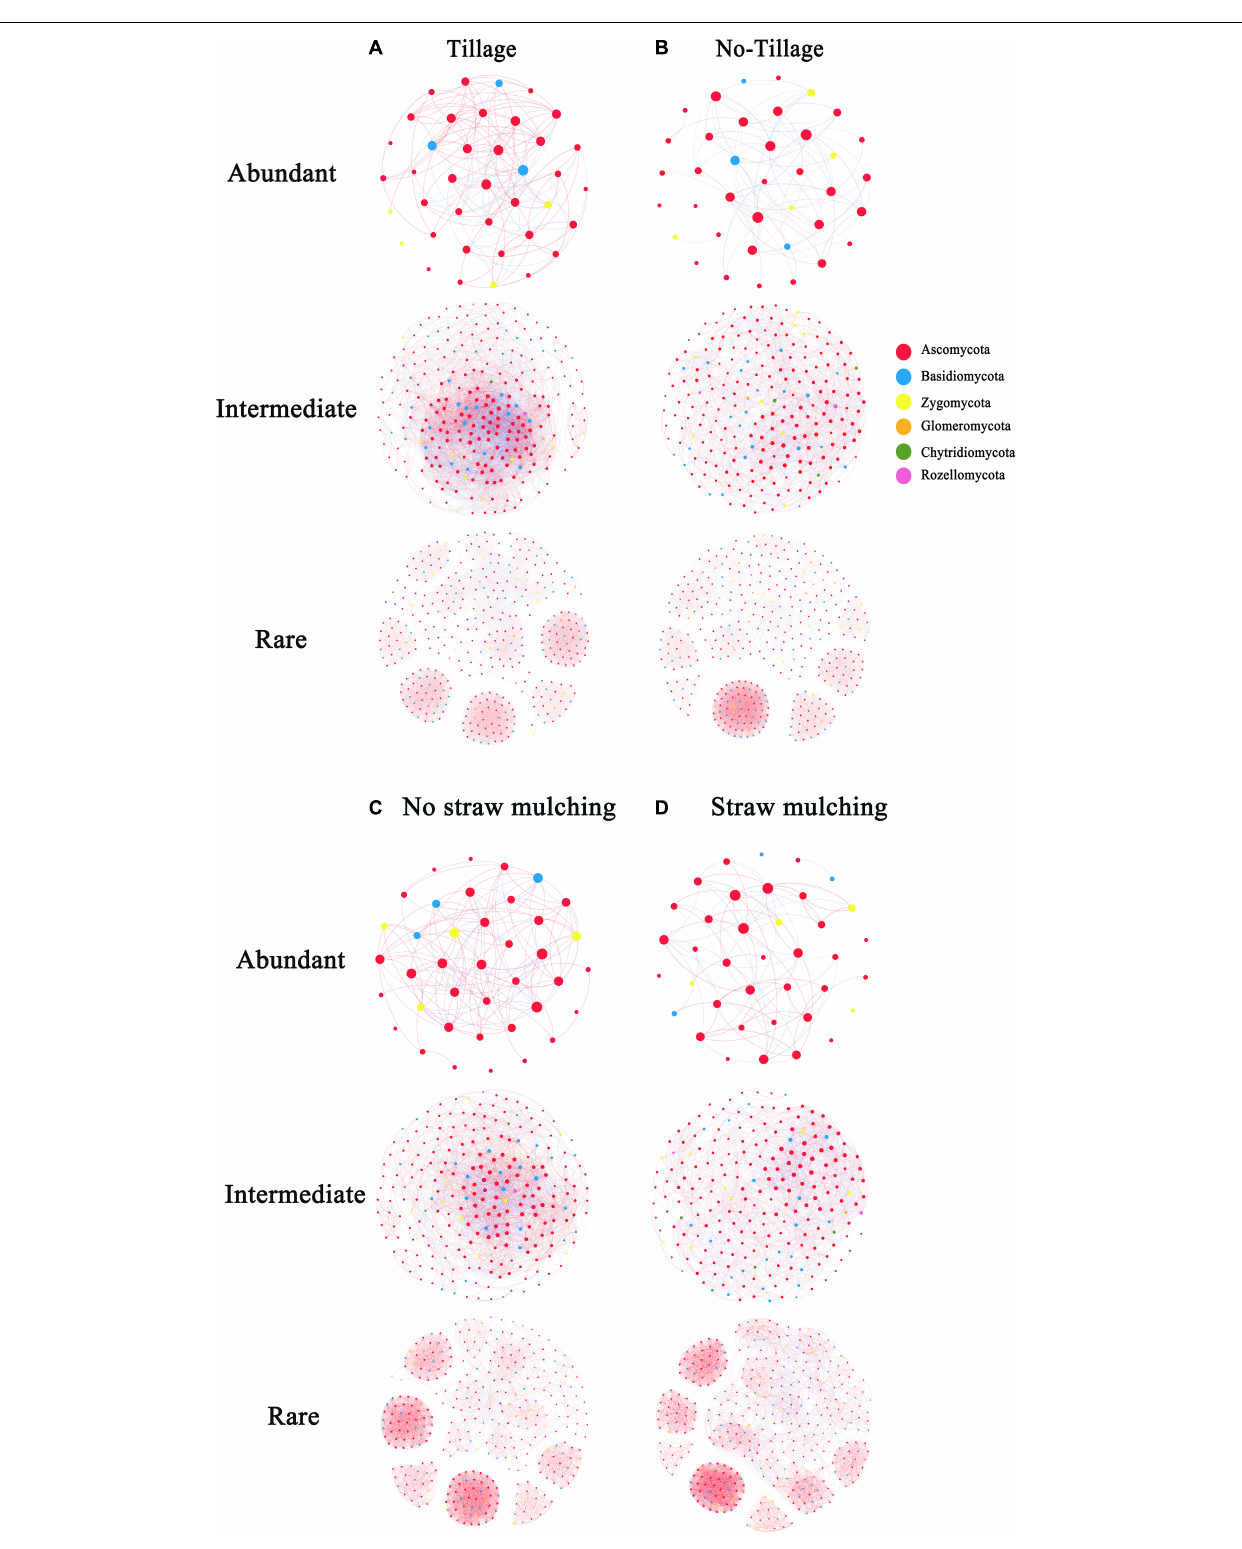
Frontiers in Microbiology |